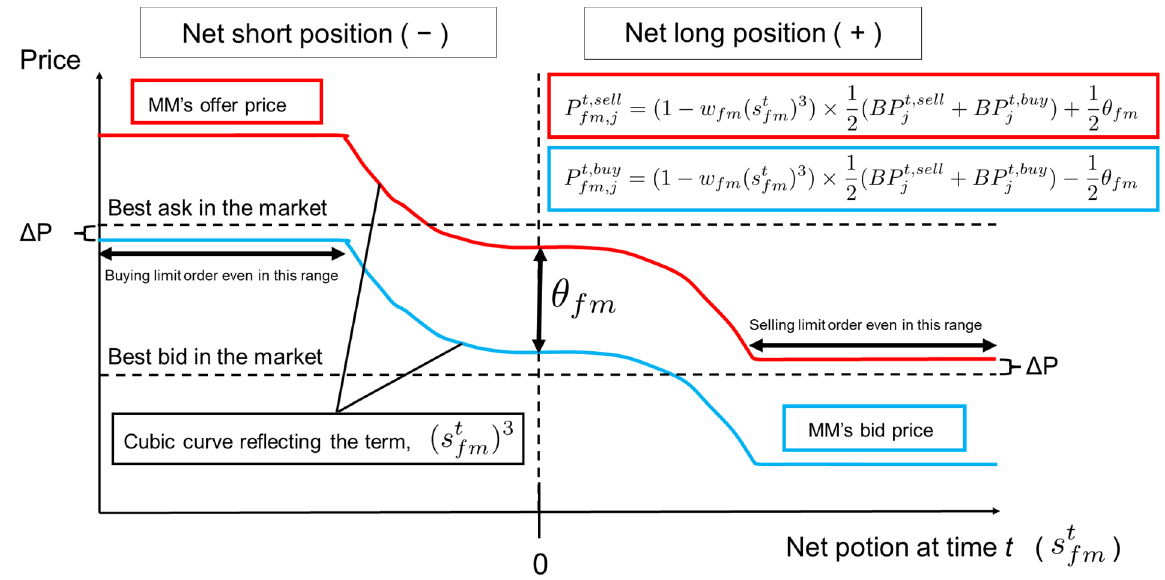
Figure 10. Price determination strategy with respect to the net position at time t , denoted by s t , of the flexible market maker when both sell and buy orders are quoted on the order board.